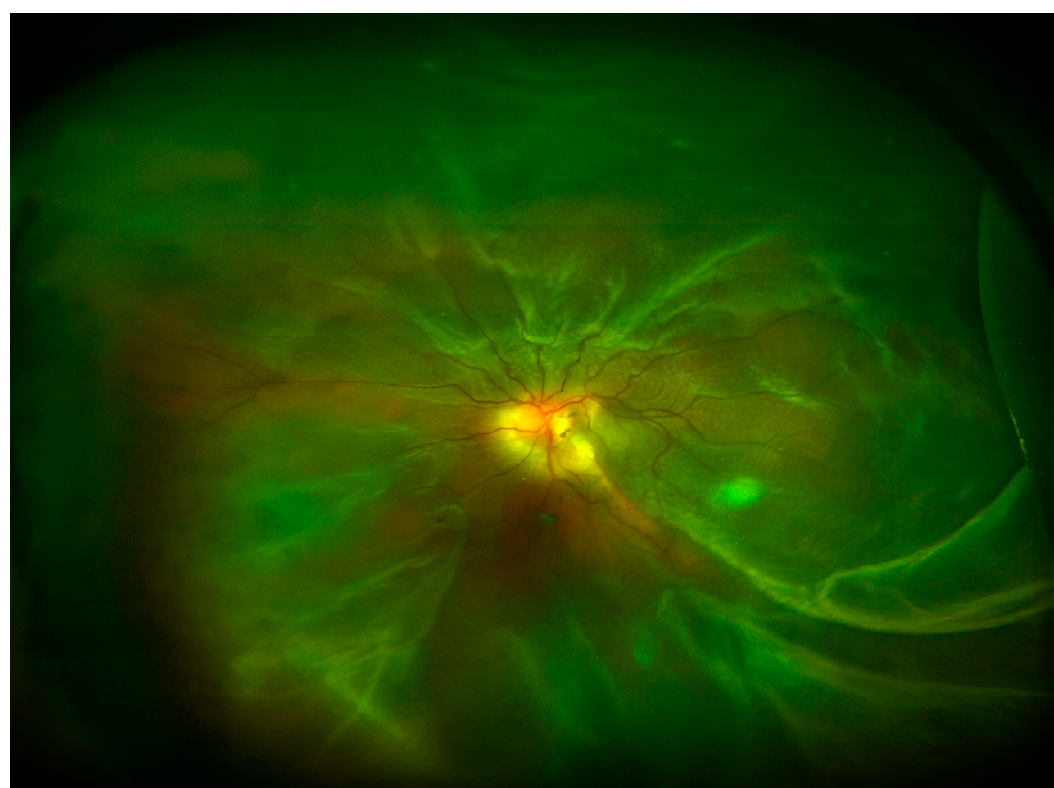
Figure 4. Ultra-wide field retinography image showing retinal detachment with PVR. Inflammatory/fibrogenic/angiogenetic growth factors/cytokines produced by injured